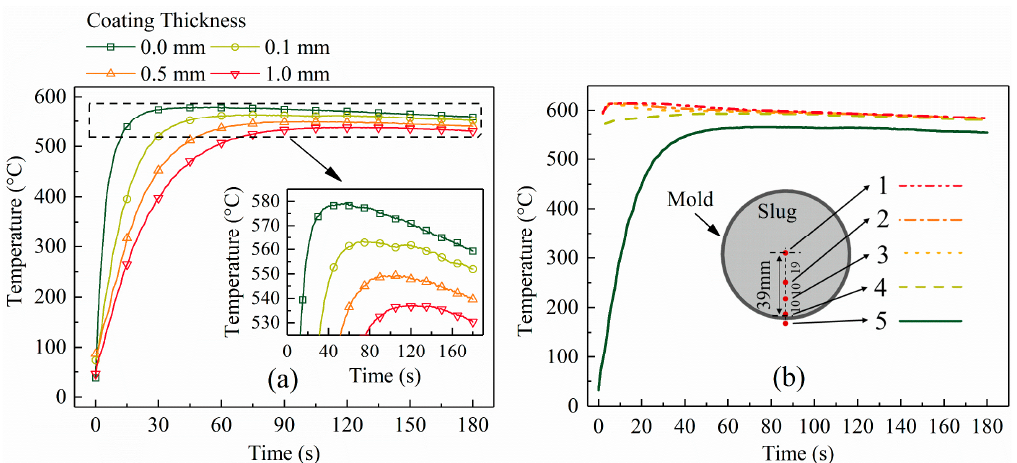
Figure 4. ( a ) Temperature evolution of external surface of the mold for different BN coating thicknesses; ( b ) temperature evolution of mold and slug (coating thickness: ~0.1 mm).